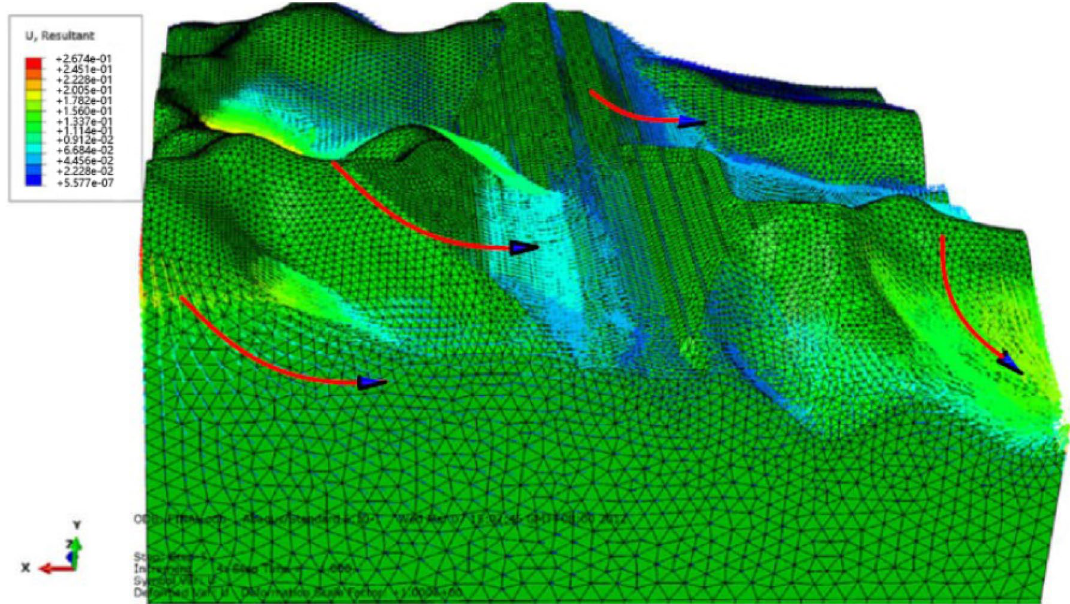
Figure 9. Potential slip trend of Lijiazhai slope incicating displacement